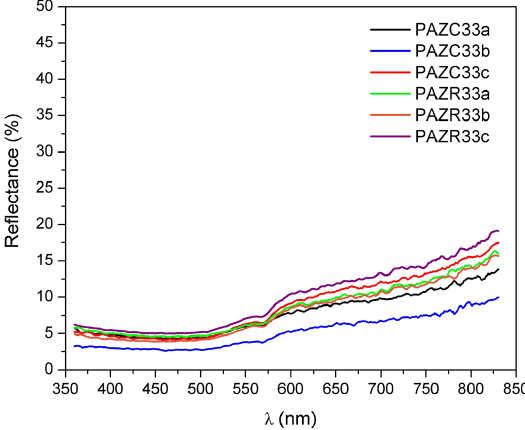
Figure 7. Diffuse reflectance spectra of the PAZC33 and PAZR33 samples after heat treatment at 1200°C. The a, b, or c indices in sample names refer to replicate